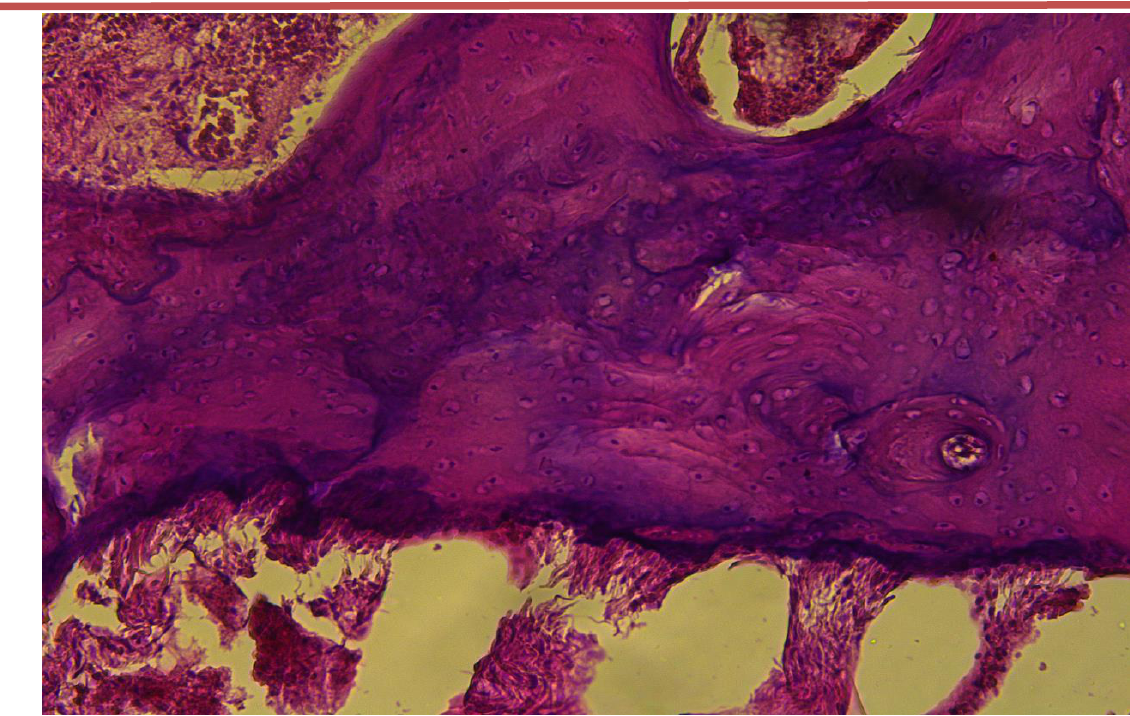
Figure (12): Low power view group4 (2 weeks).